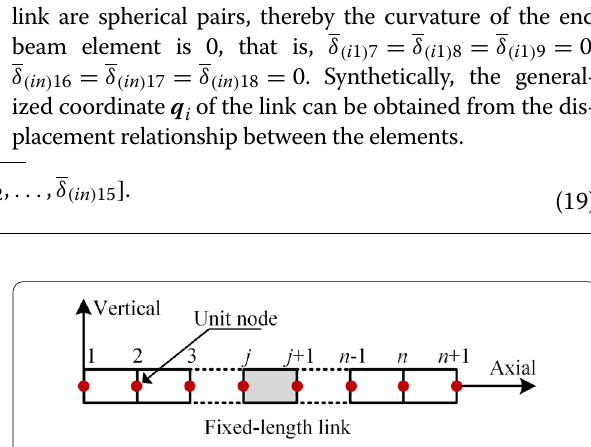
Figure 8 Division of the link